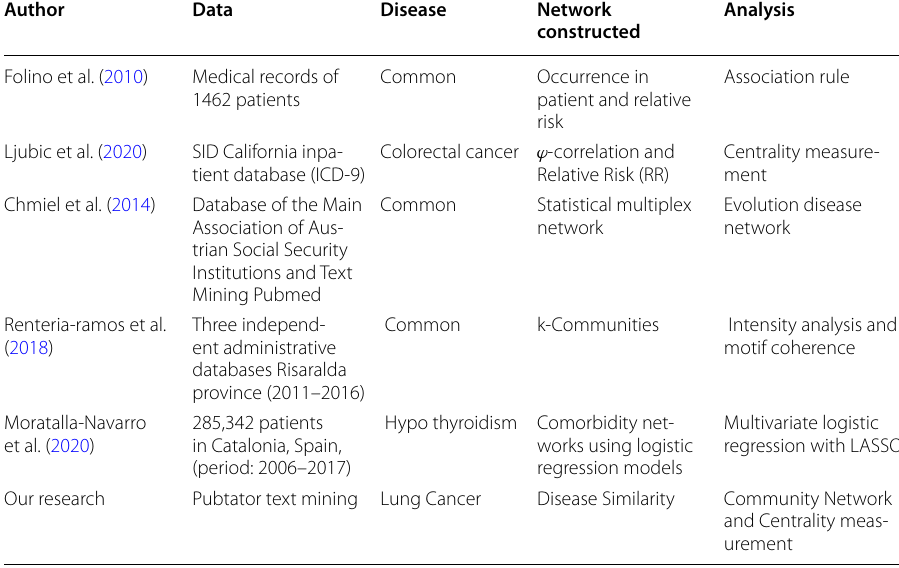
Table 8 Comparison of comorbidity network